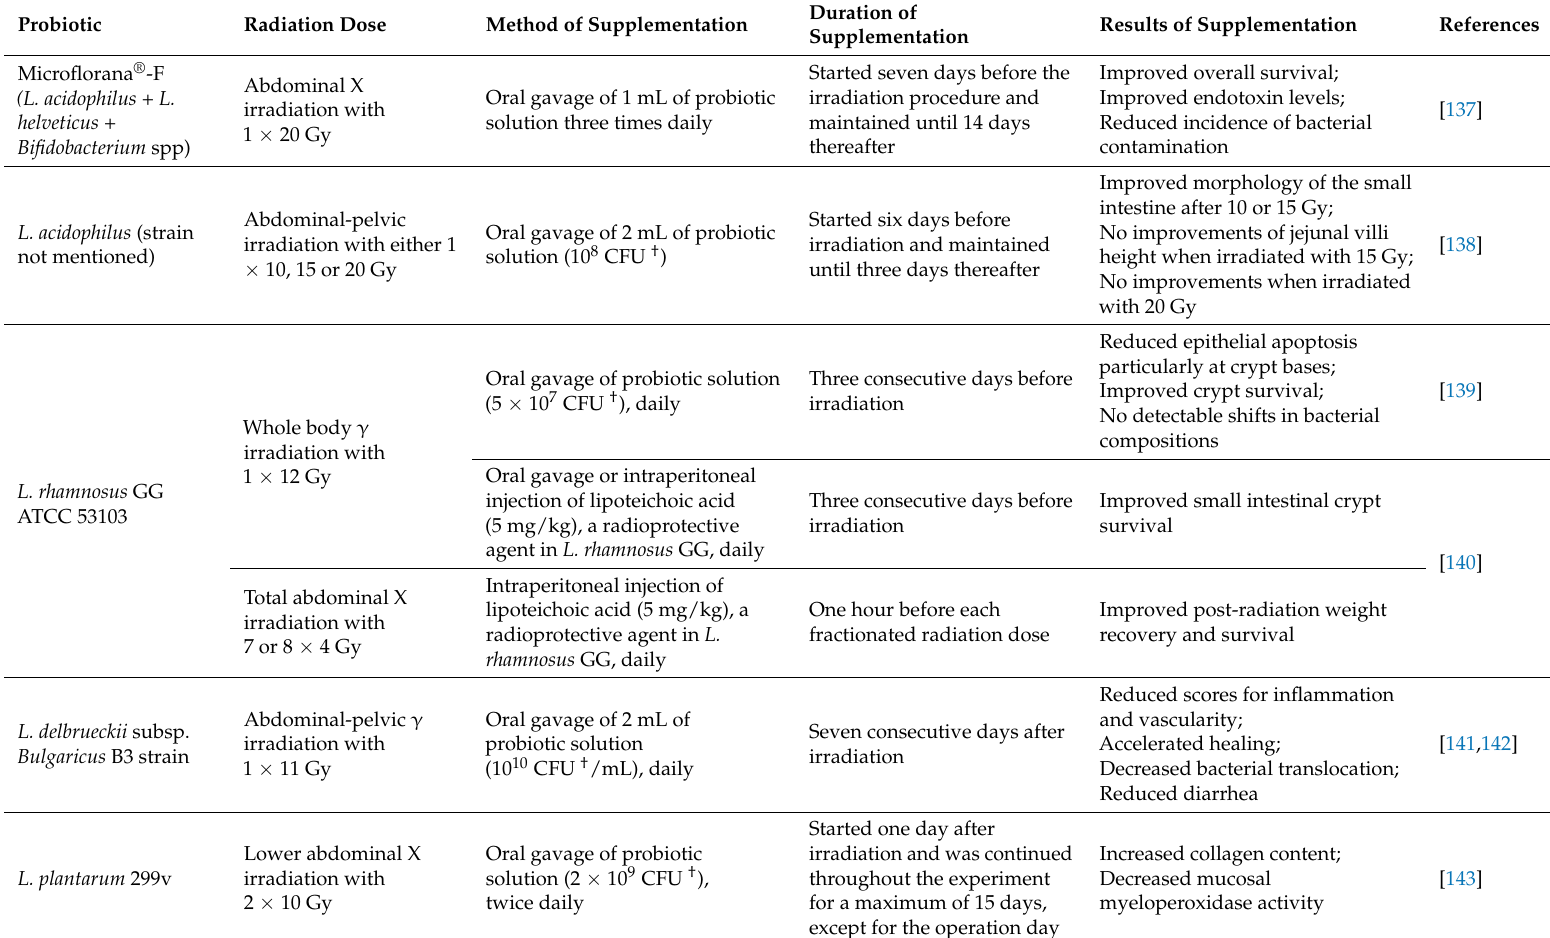
Table 2. Overview of preclinical studies on probiotic strategies for improving radiation-induced GI toxicity in tumor-free